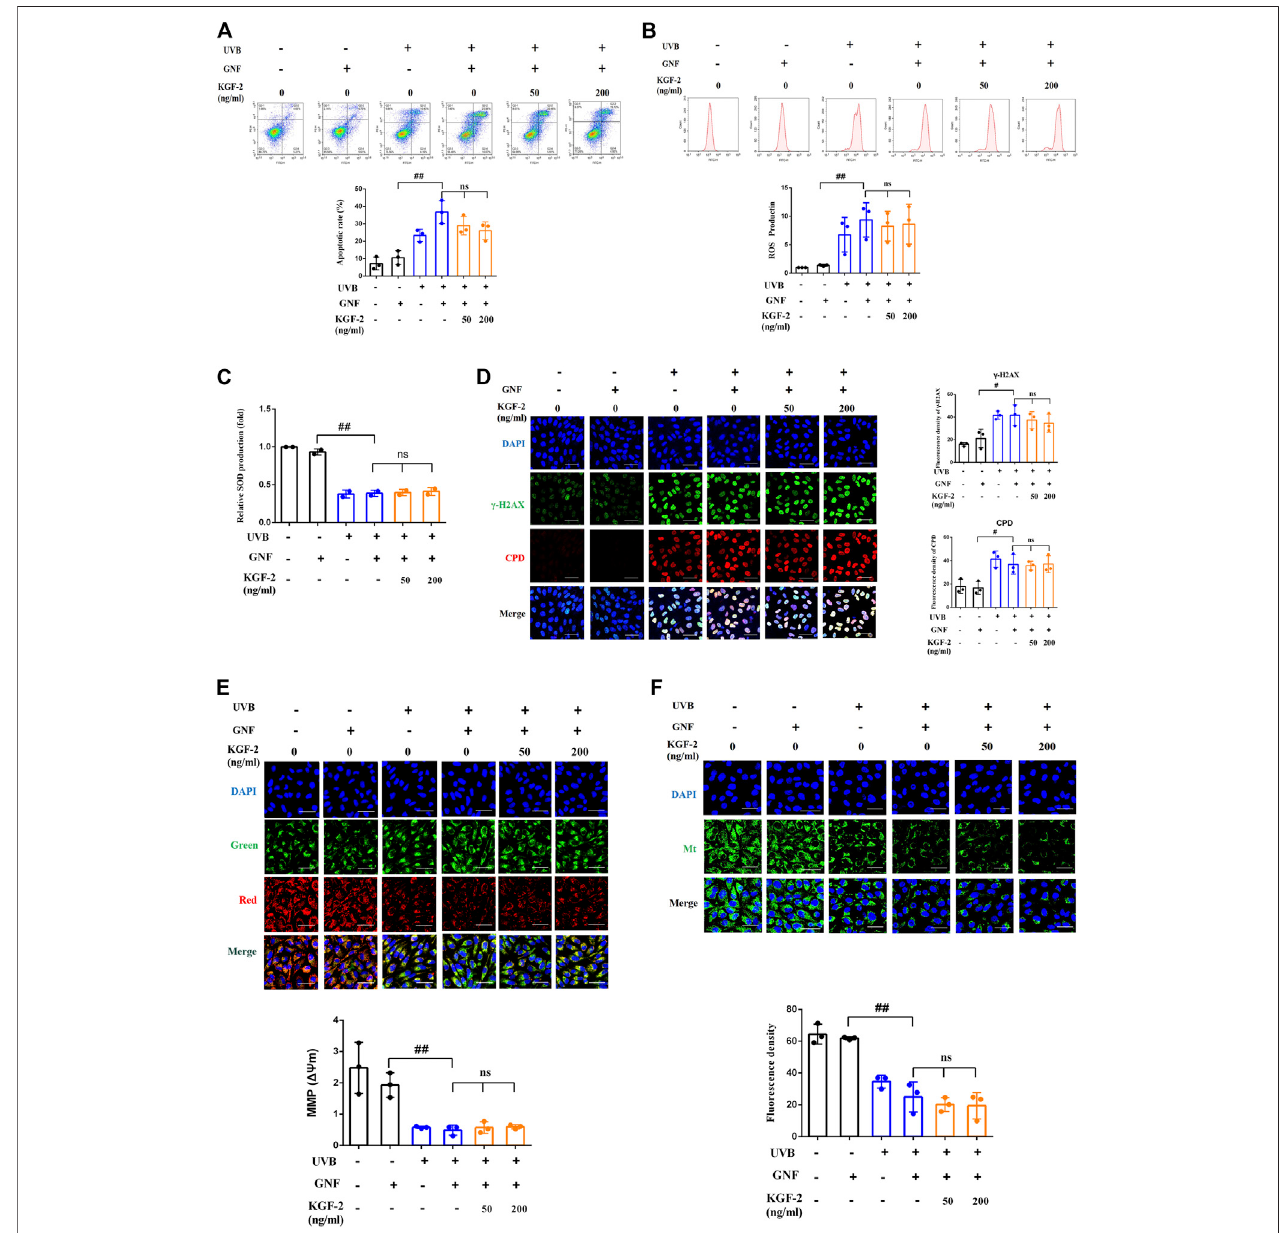
FIGURE5| HaCaTcellswerepretreatedwithorwithoutGNF351for12 hpriorandthentreatedwithKGF-2.Afterthat,thecellsweretreatedwithorwithoutKGF-2 for 4 h, and then exposed to UVB (200 mJ/cm 2 ). The protective effect of KGF-2 on the UVB-induced cell damage was then determined. (A) Flow cytometric analysis of apoptotic HaCaT cells, theplot compares the apoptotic ratesfrom three different treatments. UVB + GNF vs. GNF group, p (cid:2) 0.0001; KGF-2(50 ng/ml) vs. UVB + GNF group, p (cid:2) 0.2314; KGF-2(200 ng/ml) vs. UVB+GNF group, p (cid:2) 0.0675. (B) Representativeimage ofintracellular ROSlevels; Theplotcompares therelative ROS production from three different treatments. UVB + GNF vs. GNF group, p (cid:2) 0.0083; KGF-2 (50 ng/ml) vs. UVB + GNF group, p (cid:2) 0.9729; KGF-2 (200 ng/ml) vs. UVB + GNF group, p (cid:2) 0.9952. (C) SOD levels from different treatments. UVB + GNF vs. GNF group, p < 0.0001; KGF-2 (50 ng/ml) vs. UVB + GNF group, p (cid:2) 0.9988; KGF-2 (200 ng/ml) vs. UVB + GNF group, p (cid:2) 0.9588. (D) Representative image of immuno fl uorescence staining of CPD and γ -H2AX, the plot compares the formation of CPD and γ -H2AX from three different treatments. γ -H2AX: UVB + GNF vs. GNF group, p (cid:2) 0.0128; KGF-2 (50 ng/ml) vs. UVB + GNF group, p (cid:2) 0.8935; KGF-2 (200 ng/ml) vs. UVB+GNFgroup, p (cid:2) 0.6063.CPD:UVB+GNF vs. GNFgroup, p (cid:2) 0.0155;KGF-2(50 ng/ml) vs. UVB+GNFgroup, p (cid:2) 0.9997;KGF-2(200 ng/ml) vs. UVB+GNF group, p (cid:2) 0.9999. (E) Representativeimageofmitochondrialmembranepotential(MMP)inHaCaTcells,theplotcomparestheMMPofHaCaTcellsfromthreedifferent treatments. UVB + GNF vs. GNF group, p (cid:2) 0.0002; KGF-2 (50 ng/ml) vs. UVB + GNF group, p (cid:2) 0.99855; KGF-2 (200 ng/ml) vs. UVB + GNF group, p (cid:2) 0.9961. (F) Representative image of mitochondrial mass, the plot compares the mitochondrial mass of HaCaT cells from three different treatments. UVB + GNF vs. GNF group, p < 0.0001; KGF-2 (50 ng/ml) vs. UVB + GNF group, p (cid:2) 0.8163; KGF-2 (200 ng/ml) vs. UVB + GNF group, p (cid:2) 0.7211. All graphical data are the means ± SD from three independent experiments, “ # ” and “ ## ” indicate signi fi cantly different from the GNF only control group at the p < 0.05 and p < 0.01 levels, respectively, “ * ” and “ ** ” indicate signi fi cantly different from the UVB + GNF group at the p < 0.05 and p < 0.01 levels, respectively.